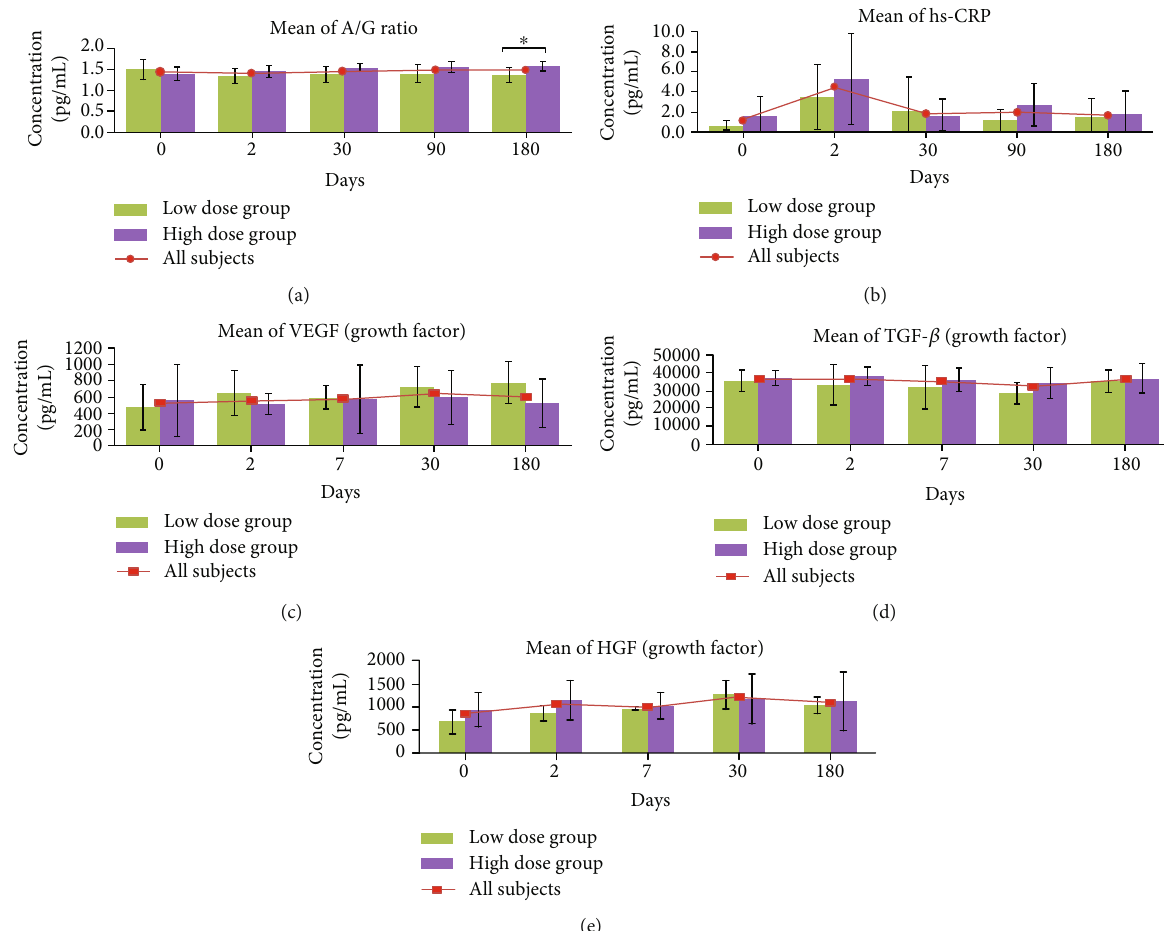
Figure 3: Evaluation of serum levels of A/G ratio, hs-CRP as well as VEGF, TGF- β , and HGF for subjects between LD and HD group. Only serum levels of A/G were found to have signi fi cant changes between both groups. Statistical signi fi cance of the biomarkers between LD and HD groups were assessed by using the Mann – Whitney test. ∗ Signi fi cant value at p < 0 : 05